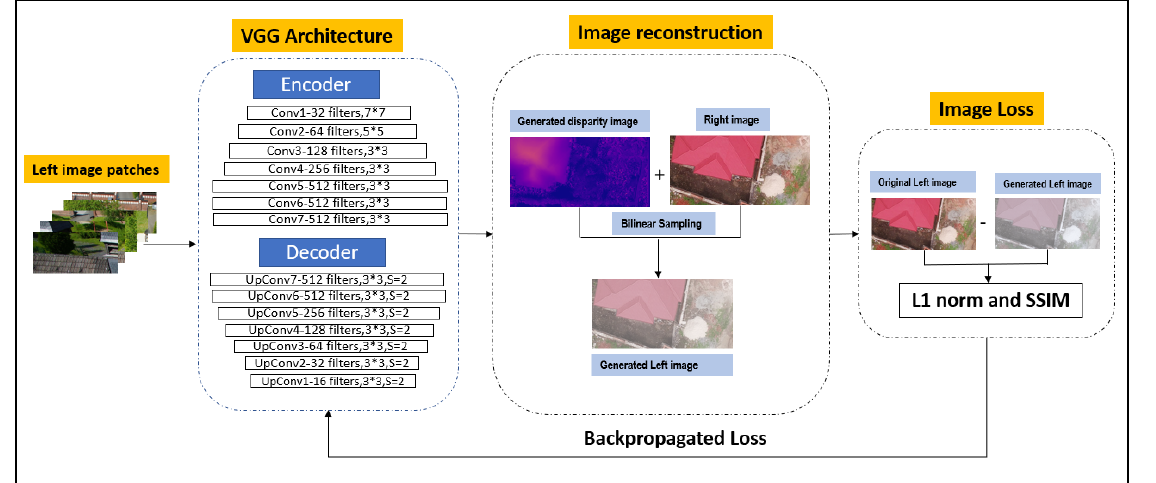
Figure 4. Simple CNN architecture with Image reconstruction loss